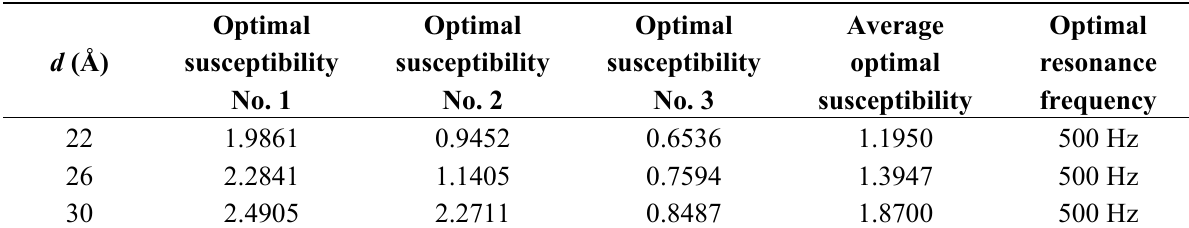
Table 1. High optimal susceptibility, average optimal susceptibility, and resonance frequency of maximum mean